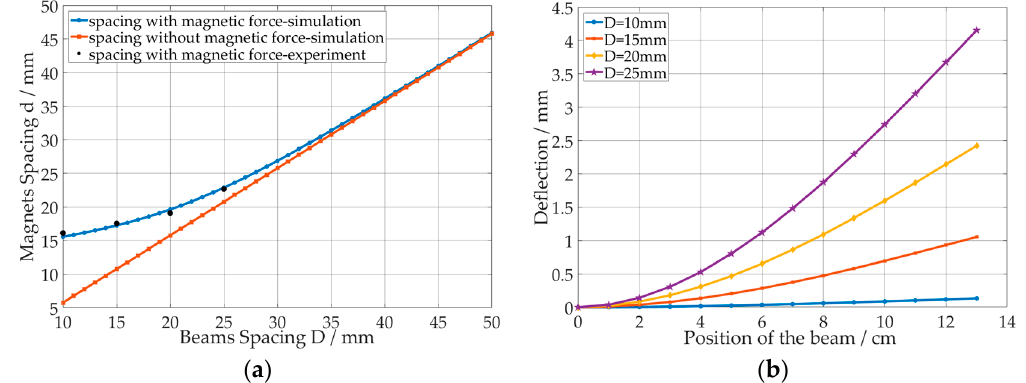
Figure 6. Static analysis curves: ( a ) Magnets Spacing; ( b ) Deflection.